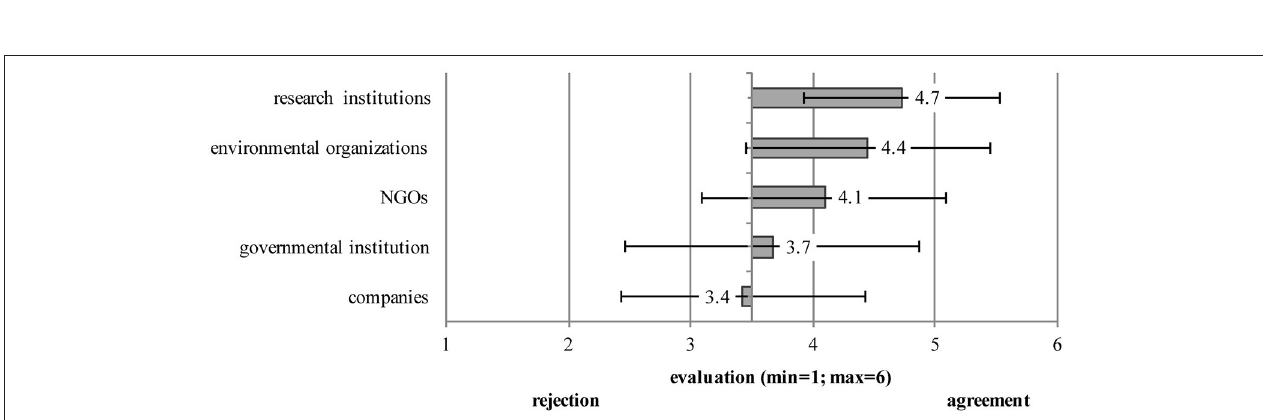
FIGURE 2 | Evaluation of the credibility of different information sources (whiskers indicate standard